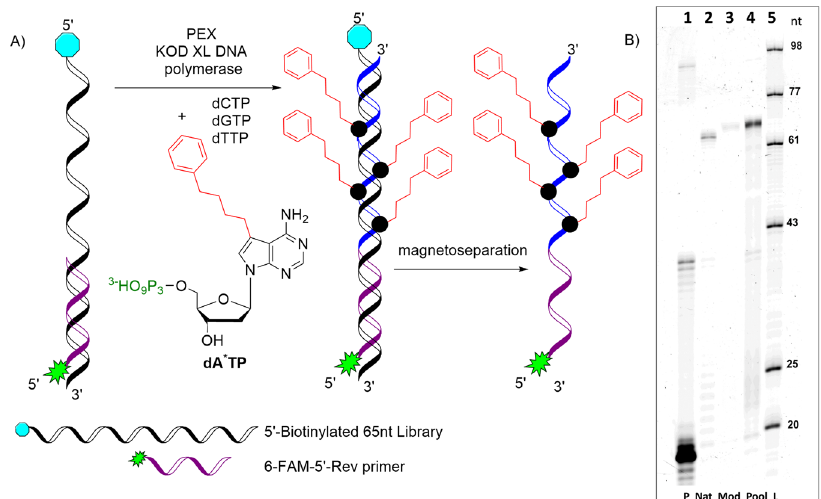
Fig. 2 Scheme of the PEX construction of modi fi ed DNA and denaturing PAGE analysis of PEX reaction with DNA random library using KOD XL DNA polymerase. Scheme of the PEX ( A ); Denaturing PAGE analysis ( B ): Lane 1 (P): primer, Lane 2 (Nat): DNA library ampli fi ed by natural dNTPs, Lane 3 (Mod): DNA library ampli fi ed with modi fi ed dA*TP and natural dCTP, dGTP, dTTP, Lane 4 (Pool): DNA library scaled-up for generation of modi fi ed starting library for SELEX, Lane 5 (L): FAM-labelled ssDNA ladder.